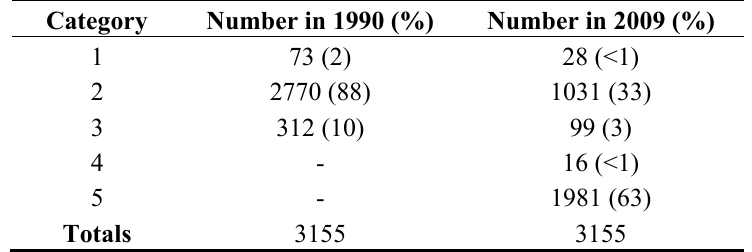
Table 1. The number of saplings in each category in 1990 and